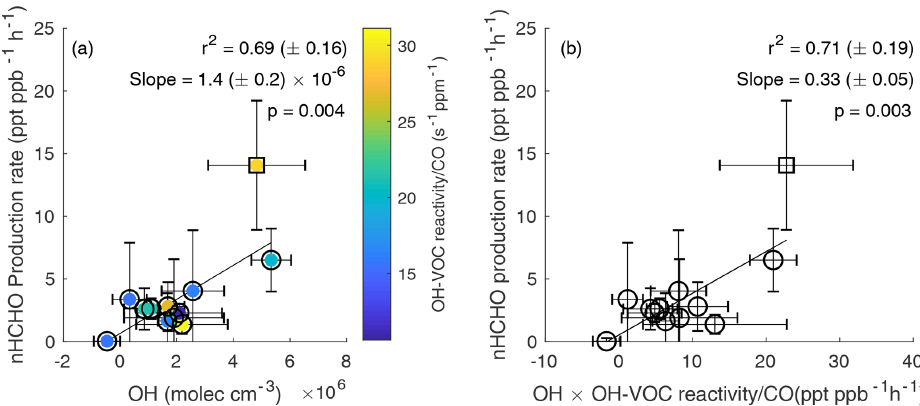
Figure 3. (a) Average secondary nHCHO production rate vs. average OH concentration, color-coded by normalized OH-VOC reactivity, for the 12 plumes including 11 western US wildfire plumes (circles) and 1 eastern US wildfire plume (square). An uncertainty-weighted linear York regression (Derek, 1968) yields a slope = 1.4 ( ± 0.2) × 10 − 6 and r 2 = 0.69 ( ± 0.16) for the 12 wildfire plumes. (b) Average secondary nHCHO production rate vs. the average product of OH and OH-VOC reactivity normalized to CO (OH × OH-VOC reactivity / CO) for each plume. An uncertainty-weighted linear York regression yields a slope = 0.33 ( ± 0.05) and r 2 = 0.71 ( ± 0.19). The slope represents the estimated effective yield α eff of HCHO per VOC molecule oxidized by OH for the US wildfires. The uncertainties in r 2 are from bootstrap analysis. The p value in each panel is to evaluate whether linear correlation is statistically significant ( p <